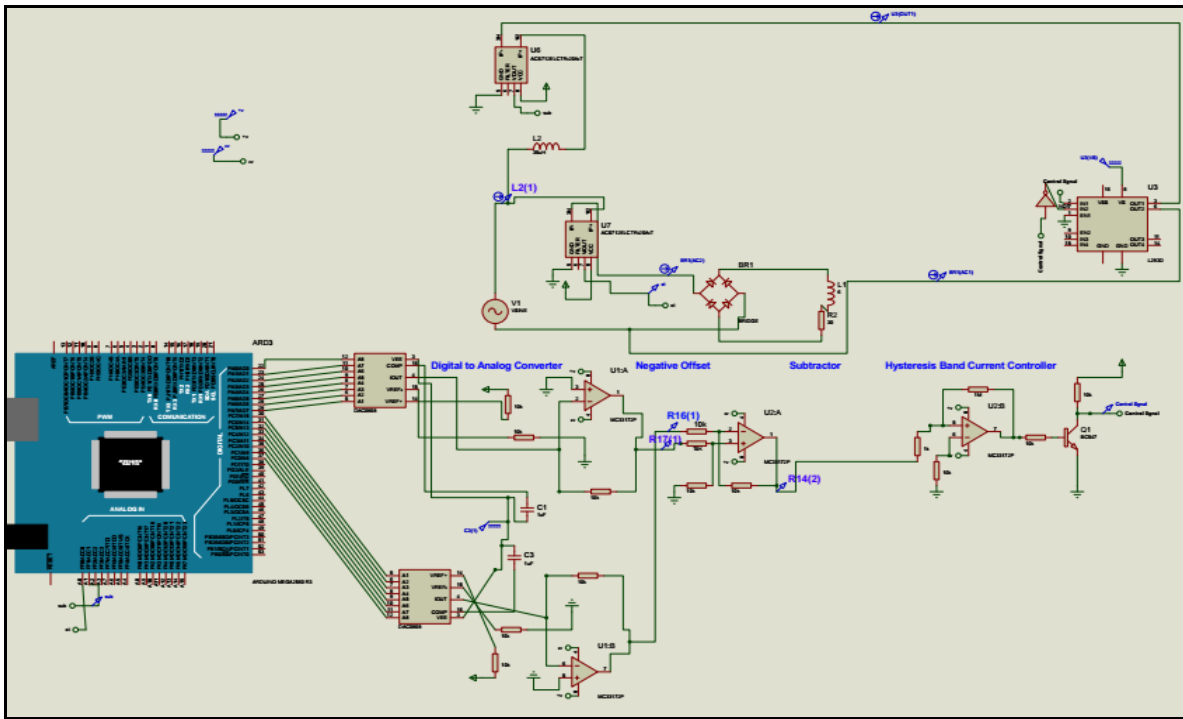
Figure 8. Implementation of H-bridge voltage source inverter using Proteus VMS.